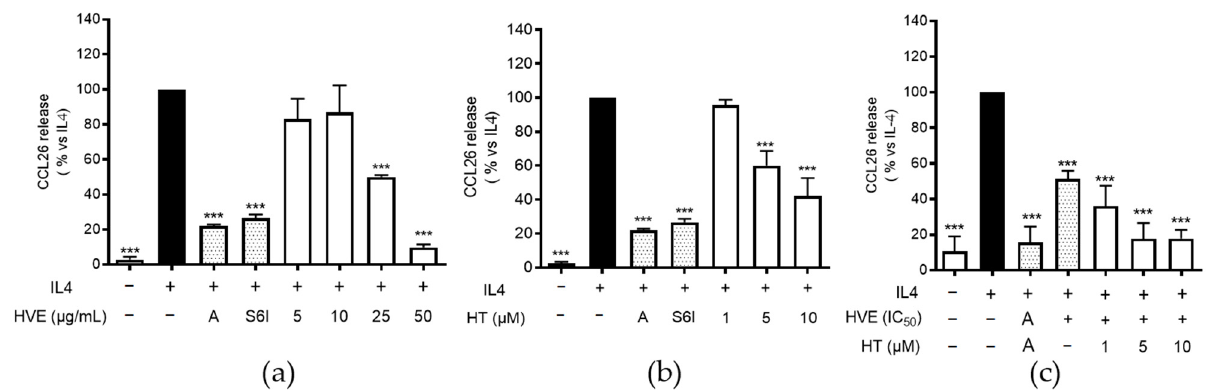
Figure 5. The inhibitory effect of HVE ( a ) and HT ( b ) treatment (24 h) on the release of CCL26 using differentiated HaCaT cells challenged by IL-4 (100 ng/mL), measured by the ELISA assay. The effect of HT (10 μ M corresponding to 4.93 μ g/mL) on HVE IC 50 (20 μ g/mL) is also reported ( c ). The data are expressed in percentages, relative to the stimulated control, which is arbitrarily assigned a value of 100%. *** p < 0.001 versus stimulus. HVE, Hamamelis virginiana bark extract; HT, hamamelitannin; reference inhibitors: A, apigenin (20 μ M); S6I, STAT-6 inhibitor (50 nM).